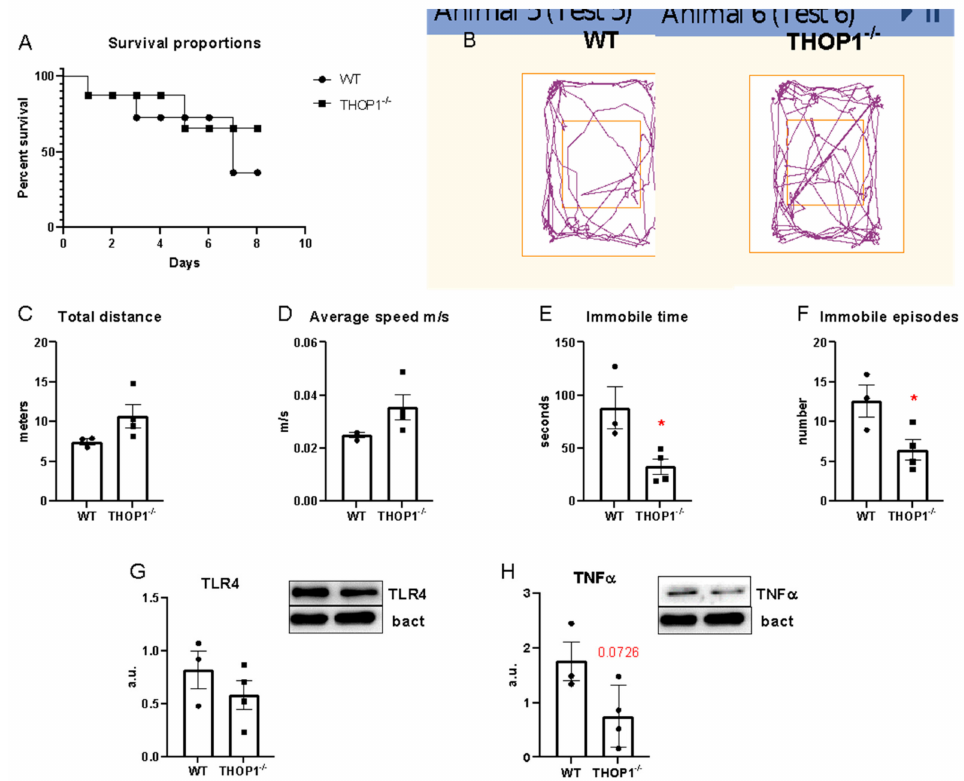
Figure 4. Survival curves and behavior analysis of mice undergoing sepsis. ( A ) THOP - / - and WT mice survivors during 7 days after sepsis induction. Next, survived animals of each group were submitted to Open Field test and Western blot analysis of dorsal hippocampus. Results were expressed as % survival during 7 days ( n = 6). ( B ) Distance tracking in open field task. ( C ) Total distance performed in Open field. ( D ) Average speed in open field ( E ) total immobility time and ( F ) total immobility episodes. ( G ) TLR4 and ( H ) TNF- α expression in total protein extract of the dorsal hippocampus. Behavior tests and Western blots were performed at the 8th day after sepsis induction. Results are expressed as mean ± S.E.M. Statistical significance was determined by Student’s t -test: * p < 0.05 vs. WT. WT. n = 3; THOP1 - / - . n =